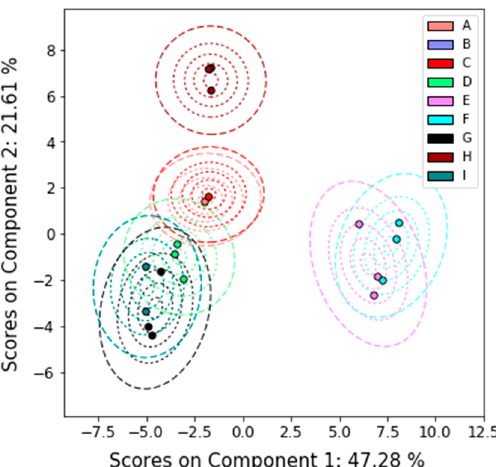
Figure 9. PCA results with uncertainty analysis on the ILS’s GC-MS data.